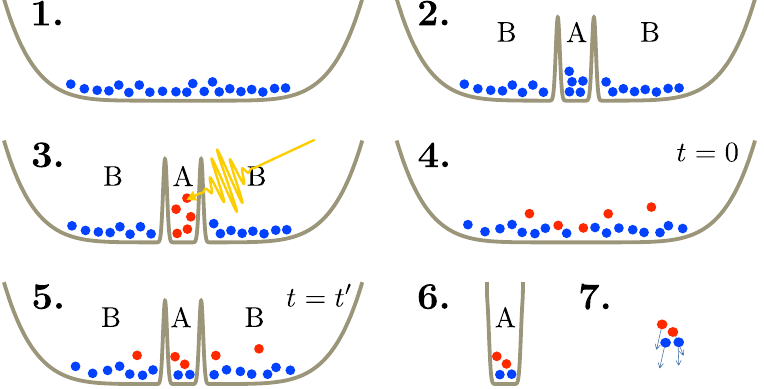
Figure 4. Cartoon of the suggested cold-atom experiment. 1. Prepare a trapped cloud of noninteracting atoms at a temperature T B . 2. Introduce a barrier that separates the system into A and a bath B . 3. Using a laser, heat up the atoms in region A to temperature T A . 4. At time t = 0 remove the barrier between A and B , letting the two subsystems thermalize. 5. After a time t = t ′ reintroduce the barrier between A and B . 6. Remove the trap around region B . 7. Remove the trap around A and perform a time-of-flight measurement of the kinetic energy of the atoms in A . The steps 1–7 should be repeated for different times t ′ to obtain the energy in A as a function of time after the